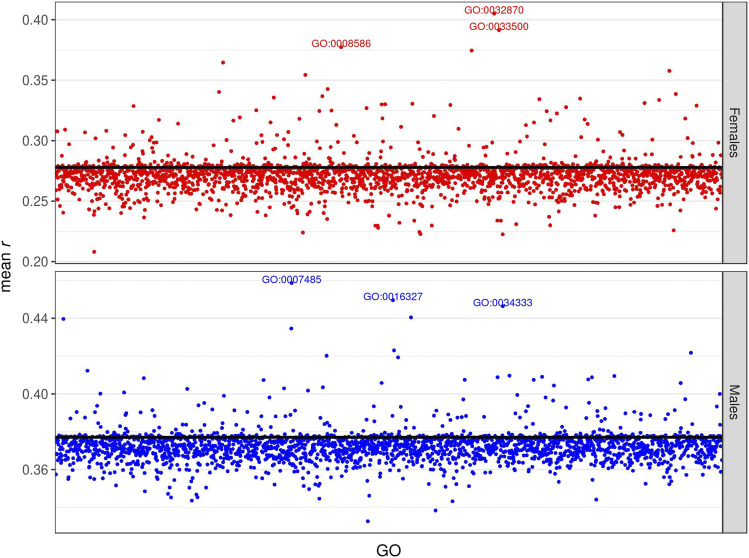
Prediction accuracy for starvation resistance, measured as mean r (on the y-axis) in the test set, obtained by the GO-TBLUP model. Each point represents the prediction accuracy achieved by a specific GO term; the top 3 most predictive GO terms are spelled out. The black horizontal line represents the accuracy of the baseline TBLUP model. The upper panel represents females, and the lower panel represents males.